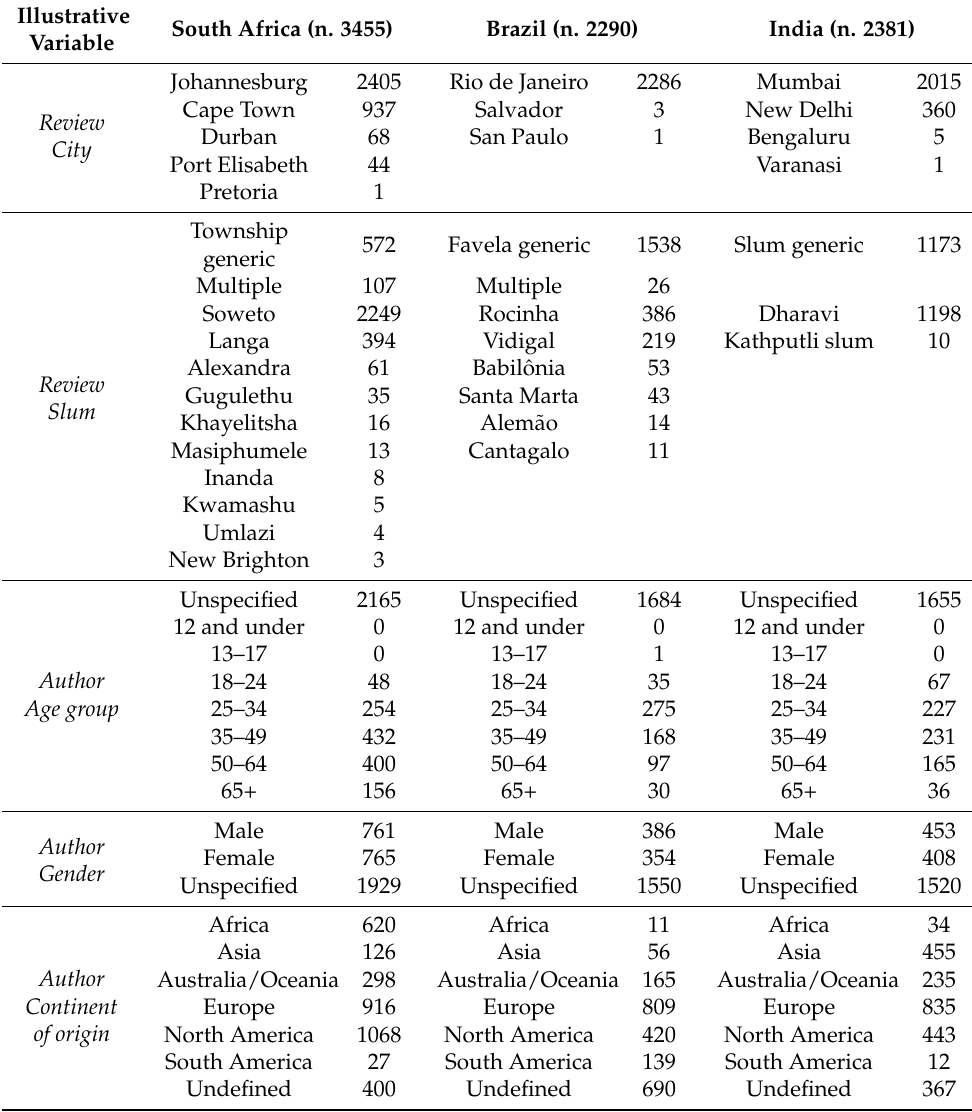
Table 1. Summary of reviews retained after screening and related illustrative